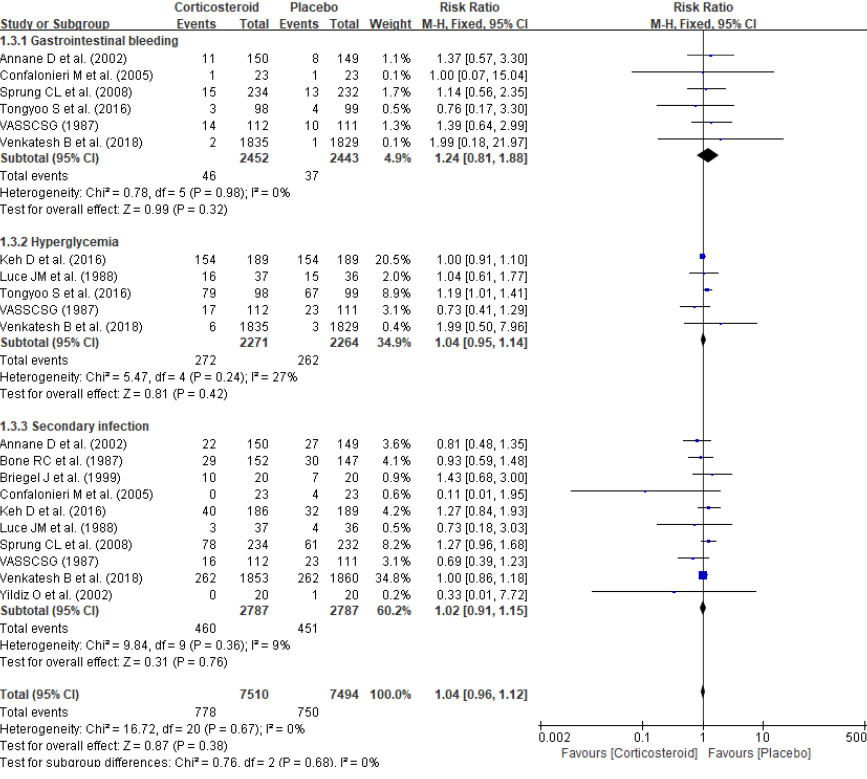
Figure 6. Forest plot of adverse events.